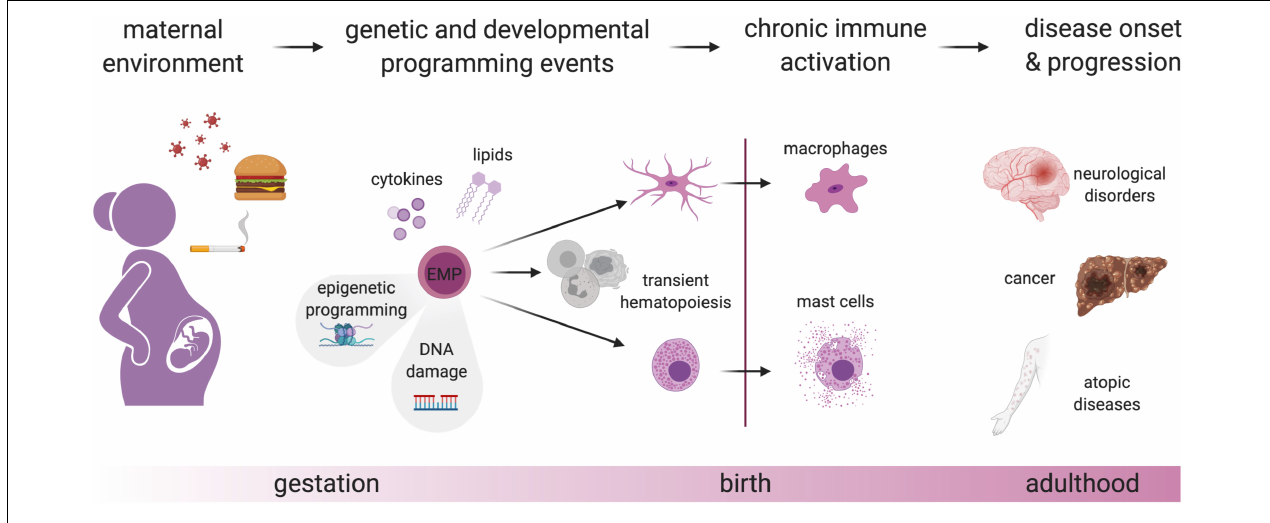
FIGURE 2 | Genetic and developmental programming of fetal-derived immune cells. Perturbation of the maternal environment e.g., by nutrition, smoking, and infection, leads to the production of mediators such as cytokines and lipids that will lead to epigenetic alterations in EMP and thereby, chronic activation of EMP-derived immune cells after birth. This switch from a homeostatic to a pro-inflammatory state due to developmental programming may cause or contribute to different diseases. In addition to naturally occurring somatic mutations in proliferating EMP and their progeny, maternal-derived hazardous materials may lead to DNA damage, which could eventually lead to a change in transcriptional programs and chronic activation of tissue-resident immune cells. Created with